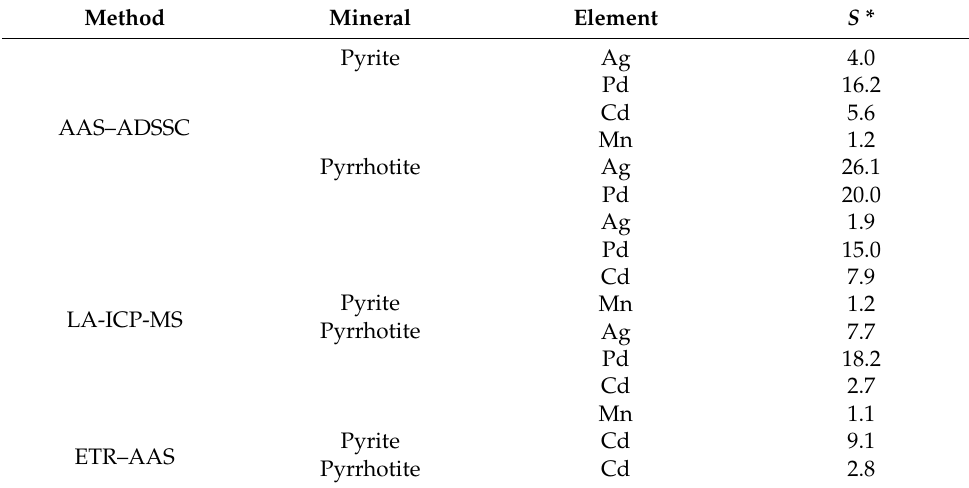
Table 5. Selectivity (S) of surficial nonautonomous phases of pyrite and pyrrhotite to the trace elements studied.